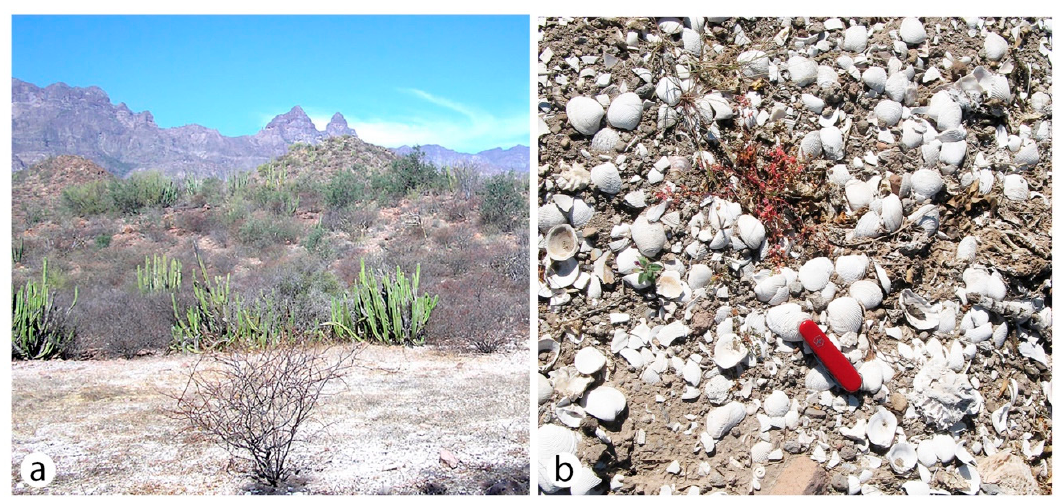
Figure 5. Upper Pleistocene shell drape in the western hills around Puerto Escondido: ( a ) View from an elevation of 45 m above sea level looking west toward the Sierra de la Gigante in the background; ( b ) Close-up view of the shell drape dominated by disarticulated vales of the Mollusk bivalve, Chione californiensis . Pocket knife for scale is 9 cm in length.